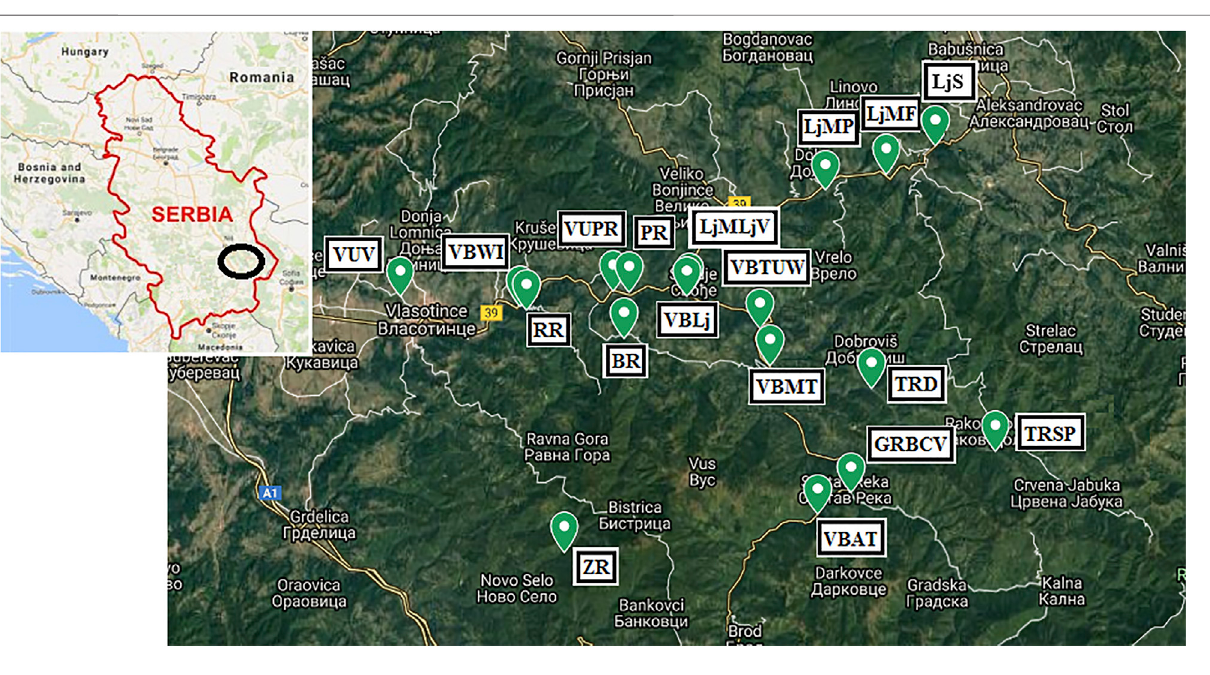
FIGURE 1 | Sampling locations: VBAT — Vlasina (before receiving any tributary); GRBCV — Gradska river (before its con fl uence with Vlasina); VBMT — Vlasina (upstream ofthecon fl uencewithTego š ni č kariver); TRSP — Tego š ni č kariver(stonepit); TRD — Tego š ni č kariver(nearvillageDobrovi š ); VBTUW — Vlasina(downstream of the con fl uence with Tego š ni č ka river, near village Gornji Orah); LjMF — Ljubera đ a (middle course); LjMP — Ljubera đ a (measuring pro fi le); LjMLjV — Ljubera đ a, (con fl uence with Vlasina); VBLj — Vlasina (after receiving Ljubera đ a); PR — Pusta river; VUPR — Vlasina (downstream of the con fl uence with Pusta river); BR — Bistri č ka river; RR — Rastavnica river; VBWI — Vlasina (upstream of the intake for water supply); VUV — Vlasina (downriver from Vlasotince); ZR — Zeleni č ka